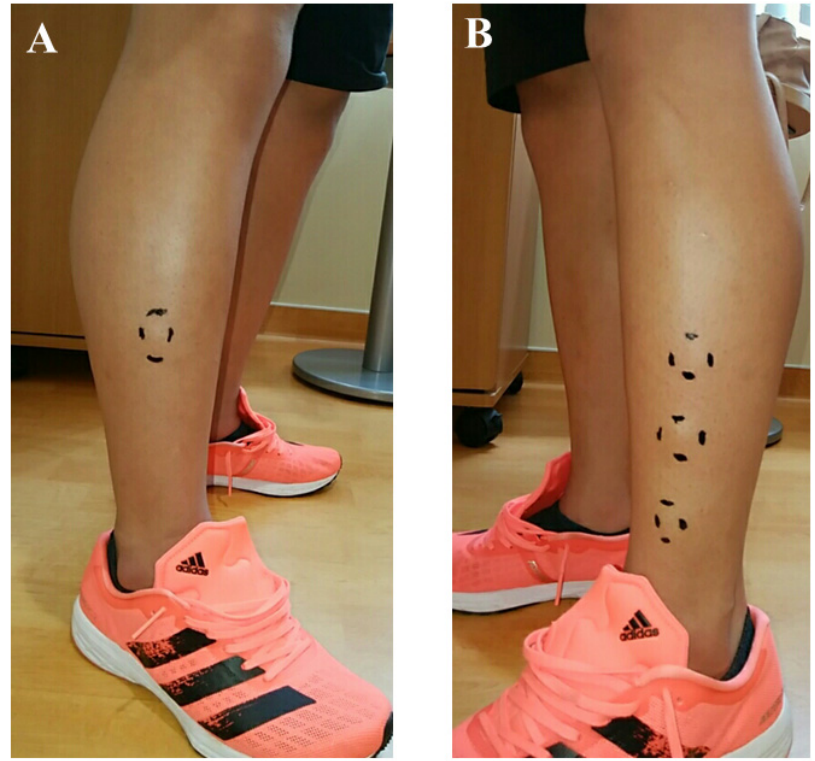
Figure 1. Preoperative photographs of the bilateral lower extremities after strenuous activity. ( A ) A swelling lesion was present in the right lower leg. ( B ) Three swelling lesions were present in the left lower leg.